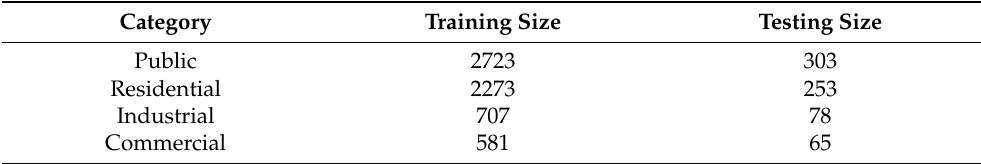
Table 9. Original sample